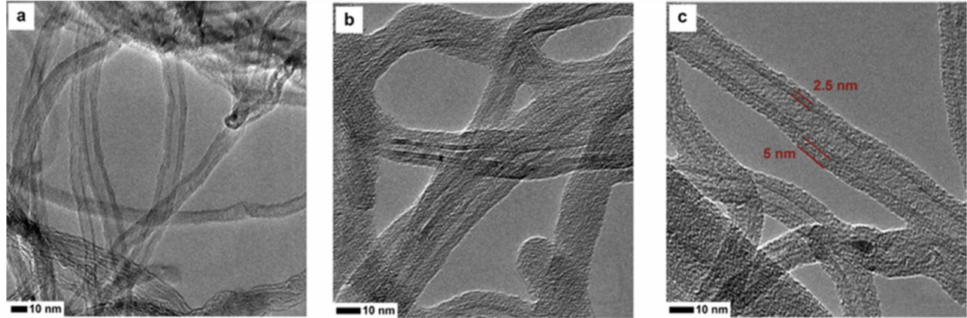
Figure 7. TEM images of ( a ) CNT and ( b , c ) CNT / nanosilica. (The average thickness of the shell of nanosilica is 5 nm). Adapted from [14], with permission from Elsevier,